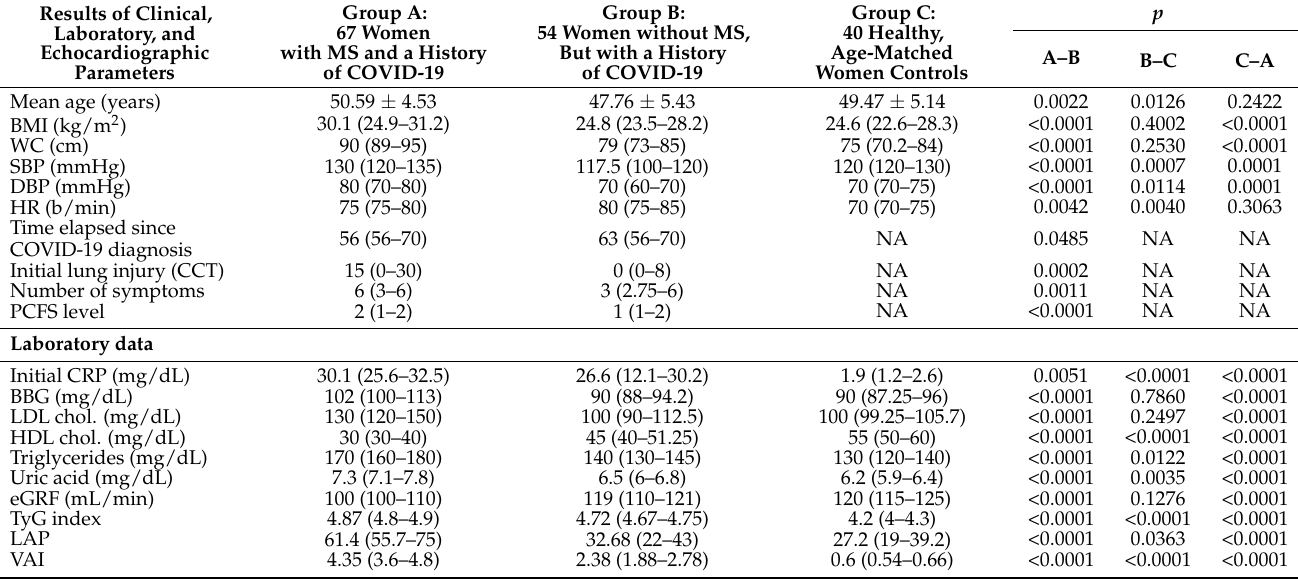
Table 2. Clinical and laboratory results of the study